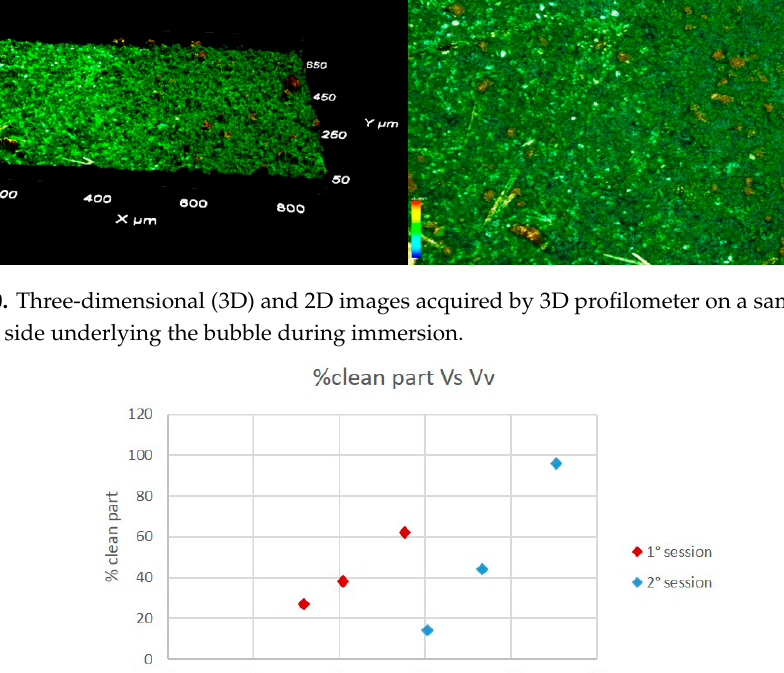
Figure 10. Three ‐ dimensional (3D) and 2D images acquired by 3D profilometer on a sample portion. The right side underlying the bubble during immersion.